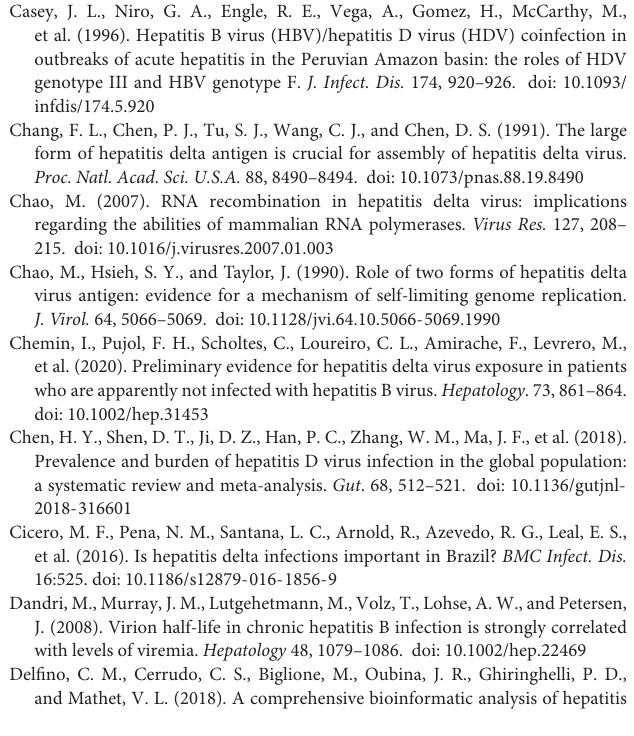
Supplementary Figure 1 | HDV RNA amplification and standard curves. HDV RNA was extracted from HuH7 cell culture supernatant, which contained either HDV-1cc, HDV-1p, or HDV-3cc virions, as described in Materials and Methods, and HDV RNA standard curves using primers and probes specific for HDV-1 (all isolates), HDV-1cc, HDV1-p, or HDV-3 were prepared in 1:5 dilutions. Supplementary Figure 2 | G/AG HDV RNAs, genome sequence and HDAgs in mice co-infected with HBV and HDV-1cc or HDV-3cc. (A) qRT-PCR measurements (dynabead based assay, see Materials and Methods) of liver G and AG HDV RNA (normalized to housekeeping gene hGAPDH) in HBV/HDV-1cc (green) and HBV/HDV-3cc (red) co-infected mice 9 weeks post infection. The bar shows median levels. (B) Sanger sequencing of genomic HDV RNA in serum of HBV/HDV-1cc and HBV/HDV-3cc co-infected mice 9 weeks post infection.